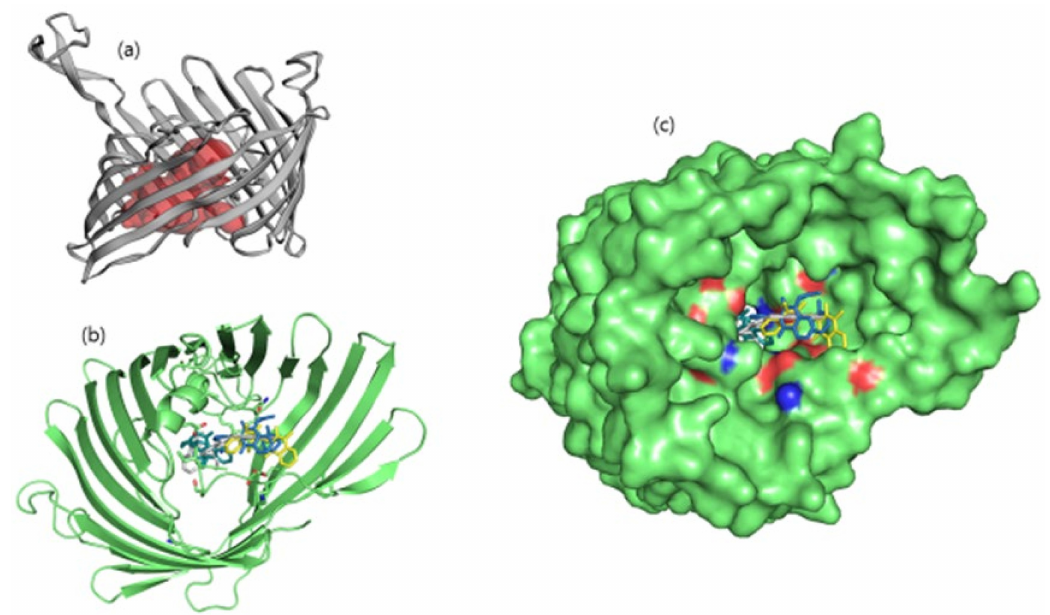
Figure 1. ( a ) Illustration of predicted protein pocket. ( b , c ) The best compounds are shown in the pocket of OmpU, as well as in a surface view depiction. Table 1. Physicochemical properties of top 24 screened phytochemicals and control compound filtered by Lipinski’s rule. S.